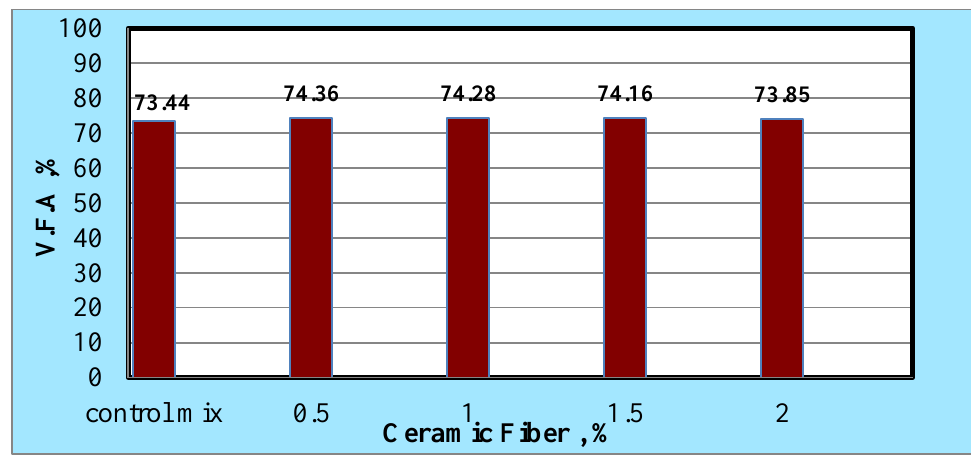
Fig. 7. Effect of Ceramic Fiber on V.F.A of Asphalt